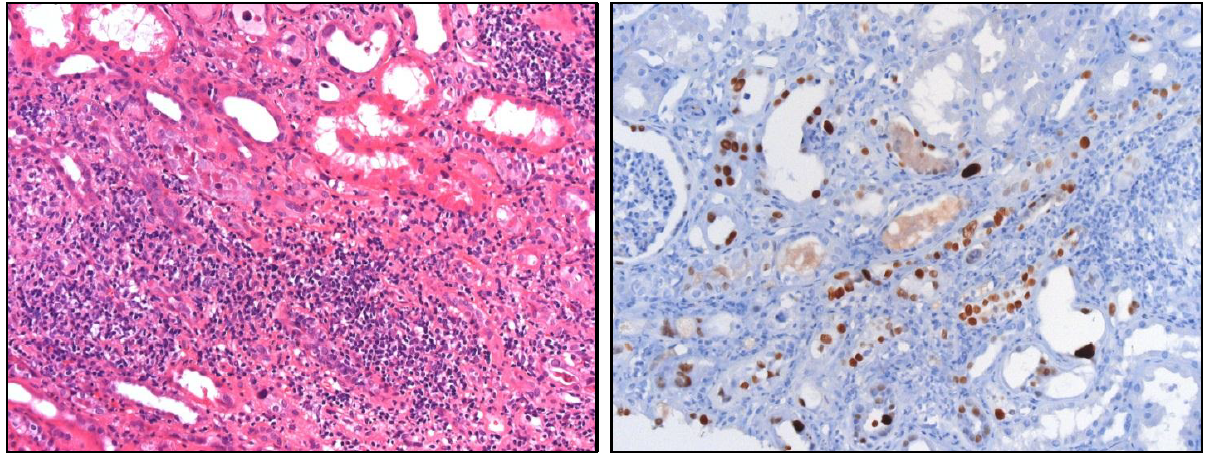
Figure 3. Interstitial nephritis in polyoma (BK) virus nephropathy. Local activation of inflammation can destroy renal parenchyma and cause acute kidney injury. In this example of BK virus reactivation in a kidney allograft was proven by immunostaining for BK viral protein with positivity in affected tubular epithelial cells ( right ). Viral replication activates antiviral immunity and immunopathology as evidenced by the dense leukocyte infiltrates in the renal interstitium ( left ). Original magnification